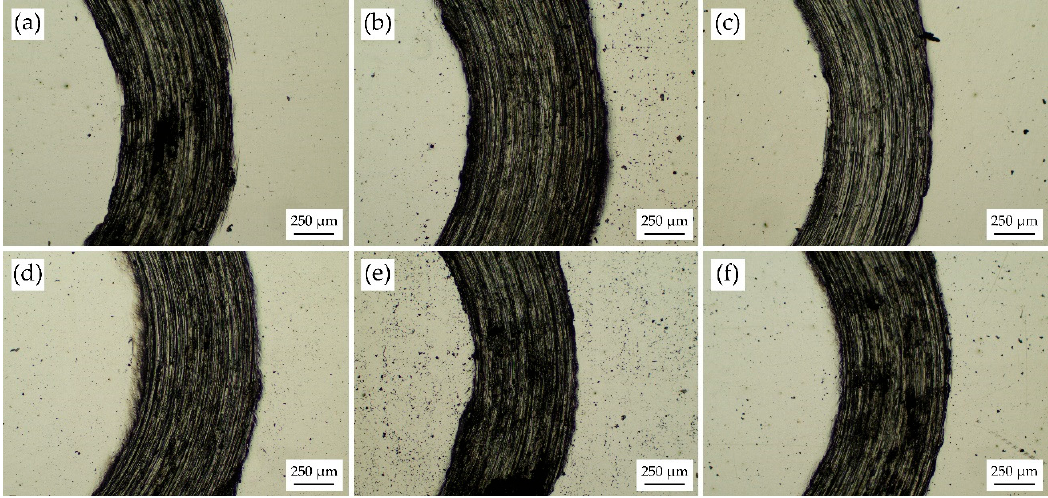
Figure 15. OM images from the worn tracks of the following specimens. ( a ) air-1.1; ( b ) air-2.2; ( c ) air-